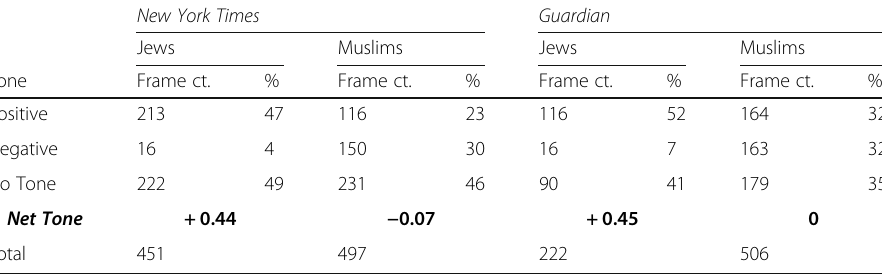
Table 3 Net Tone by Newspaper and